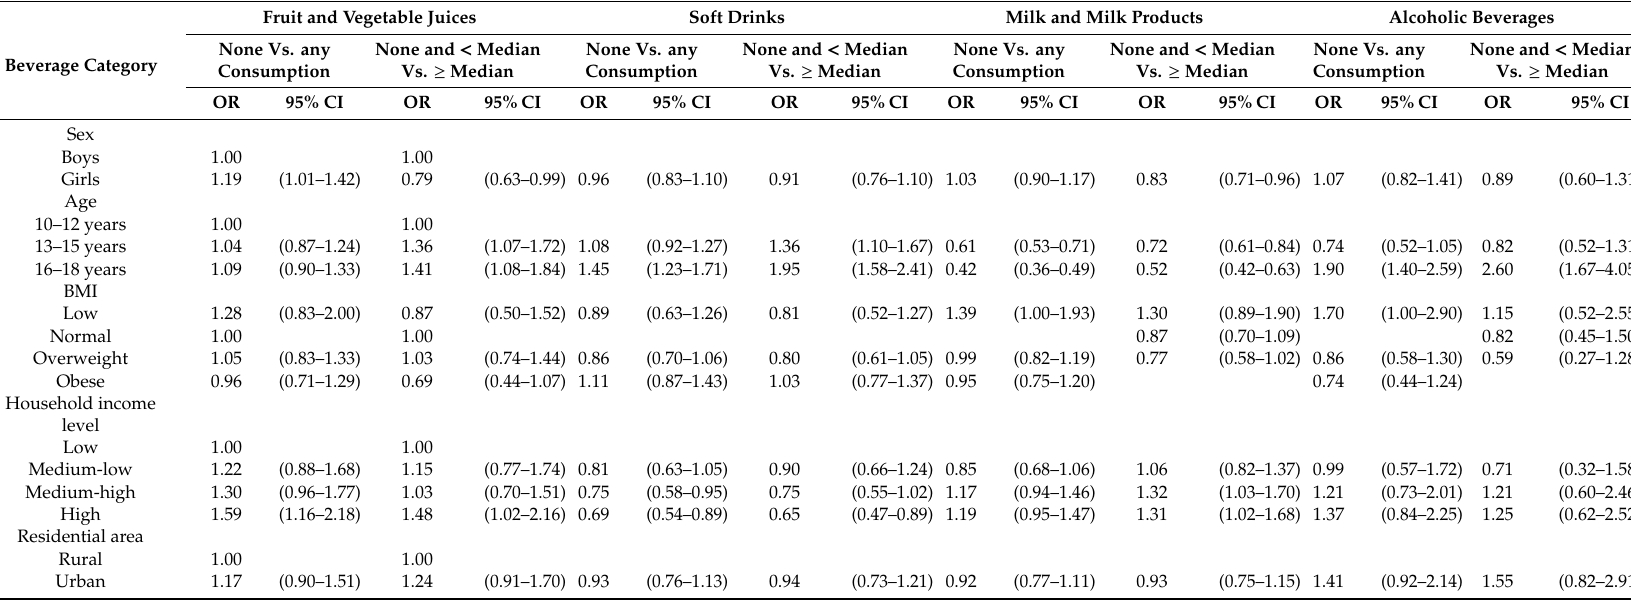
Table 4. Association between general characteristics and types of beverage consumption among the Korean children and adolescents based on the KNHANES V, VI and VII